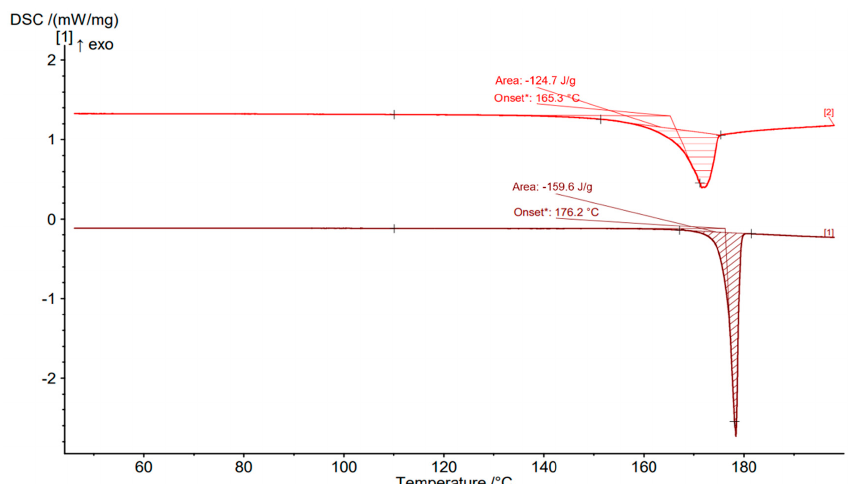
Figure 3. DSC thermograms obtained for pierced pans (top curve) and sealed pans (bottom curve). A heating rate of 2 K/min until 200 °C was used for pierced pans. For sealed pans, the solid was